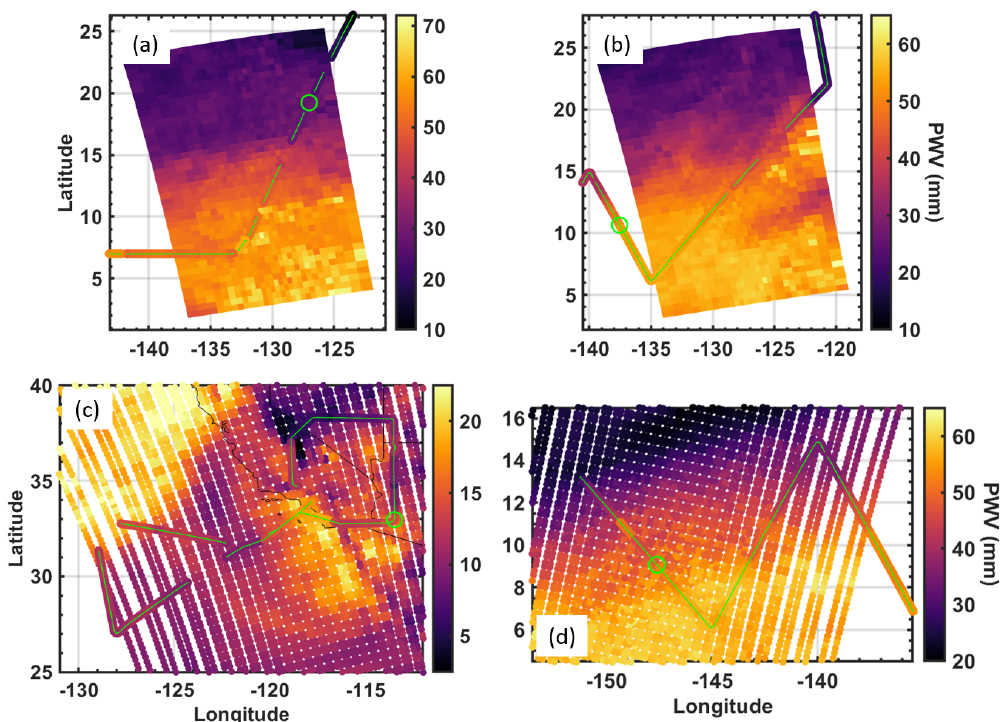
Figure 10. (a, b) AIRS and (c, d) IASI PWV with HALO PWV overlaid. The HALO PWV has a green line at the center of the flight track for visibility. Green circles mark the time that the satellite overpassed. Gaps in the HALO data are due to clouds or missing data preventing full-column PWV retrieval. Dates are (a) 25 April, (b, d) 27 April, and (c) 23 April.